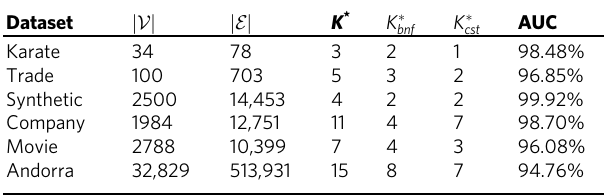
Table 1 Learning results and link fi tting performance of learned endowment